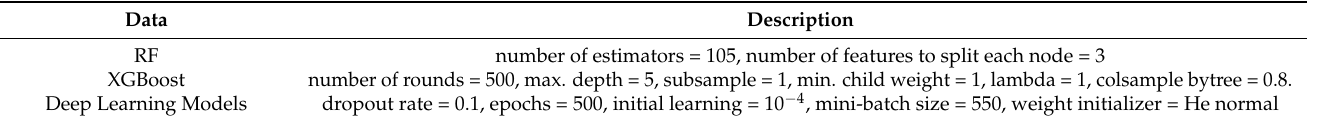
Table 3. The optimum values of the classifier